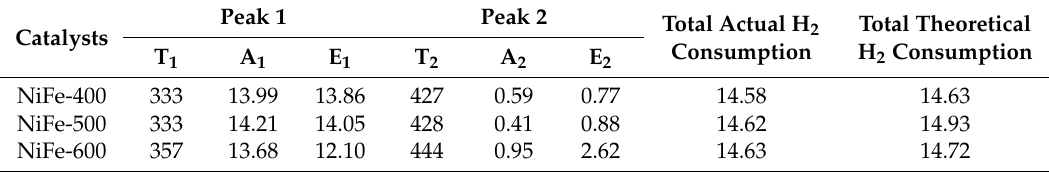
Table 4. Surface atomic concentration and oxidation states.